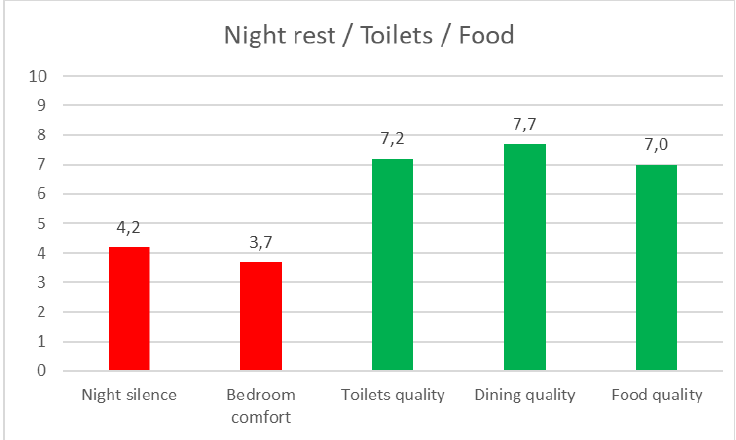
Figure 14. Night rest/Toilets/Food.